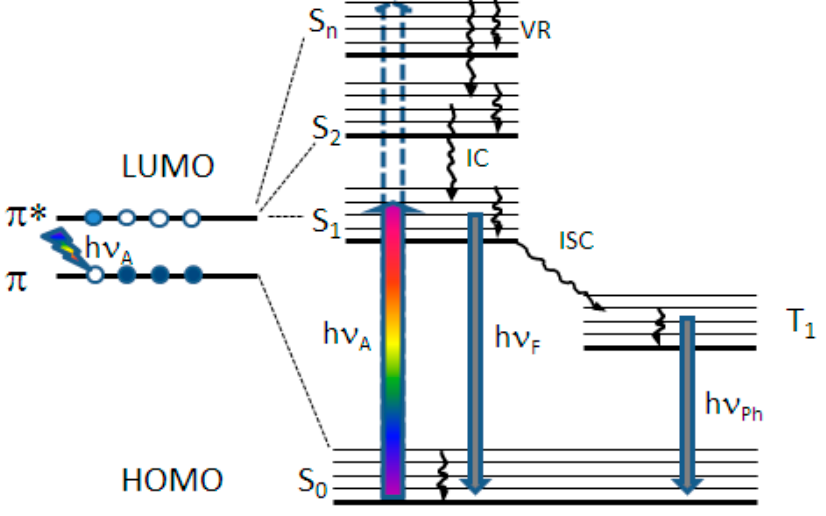
Figure 7. Term scheme illustrating the principle of an optical pump (multi-color arrow, h ν A ) and X-ray probe experiment for a typical organic molecule. The optical pump pulse tuned to a transition between S 0 and an excited state of the molecule (S 1 , S 2 , . . . ) creates a vacancy in the highest occupied molecular orbital (HOMO), which is detected by an X-ray pulse tuned to the K- or L-absorption edge of the atom of interest. LUMO denotes the lowest unoccupied molecular orbital related to an excited singlet state of the molecule. h ν F : fluorescence, h ν Ph : phosphorescence, IC: internal conversion, VR: vibrational relaxation. ISC: intersystem